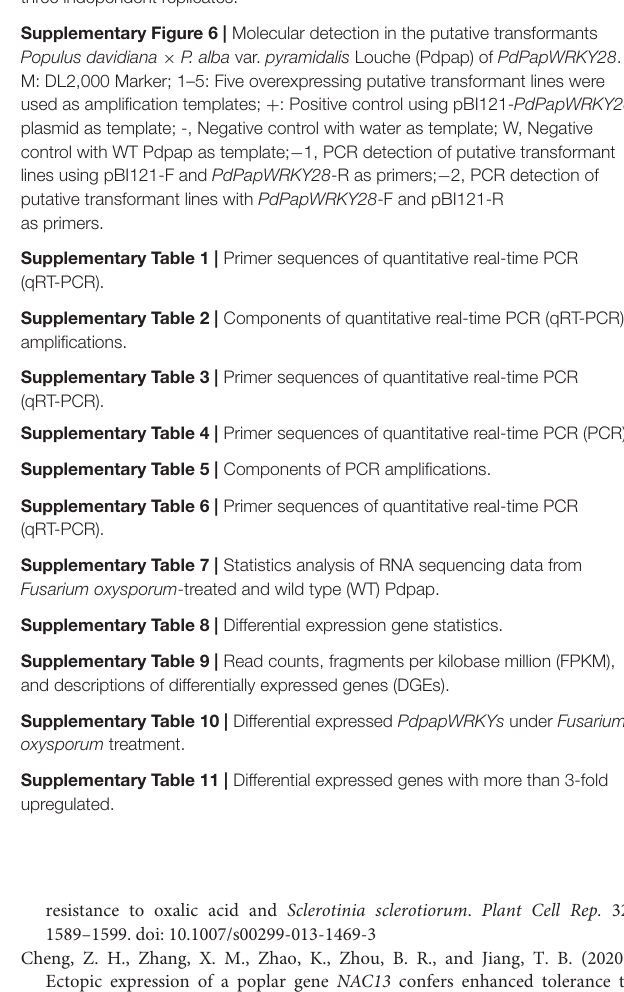
different lowercase letters. Error bars represented the standard deviation of the three independent replicates. Supplementary Figure 6 | Molecular detection in the putative transformants Populus davidiana × P. alba var. pyramidalis Louche (Pdpap) of PdPapWRKY28 . M: DL2,000 Marker; 1–5: Five overexpressing putative transformant lines were used as amplification templates; + : Positive control using pBI121- PdPapWRKY28 plasmid as template; -, Negative control with water as template; W, Negative control with WT Pdpap as template; − 1, PCR detection of putative transformant lines using pBI121-F and PdPapWRKY28 -R as primers; − 2, PCR detection of putative transformant lines with PdPapWRKY28 -F and pBI121-R as primers. Supplementary Table 1 | Primer sequences of quantitative real-time PCR (qRT-PCR).